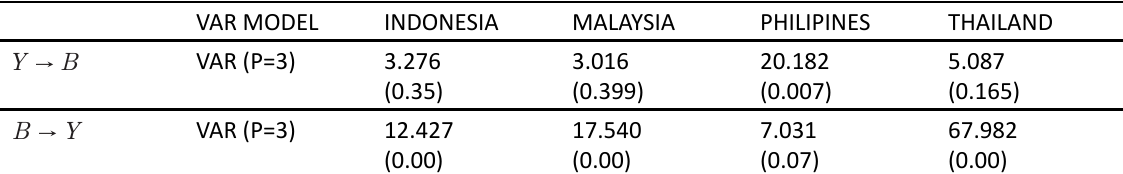
Table 4: Toda-Yamamoto- Granger causality test result VAR